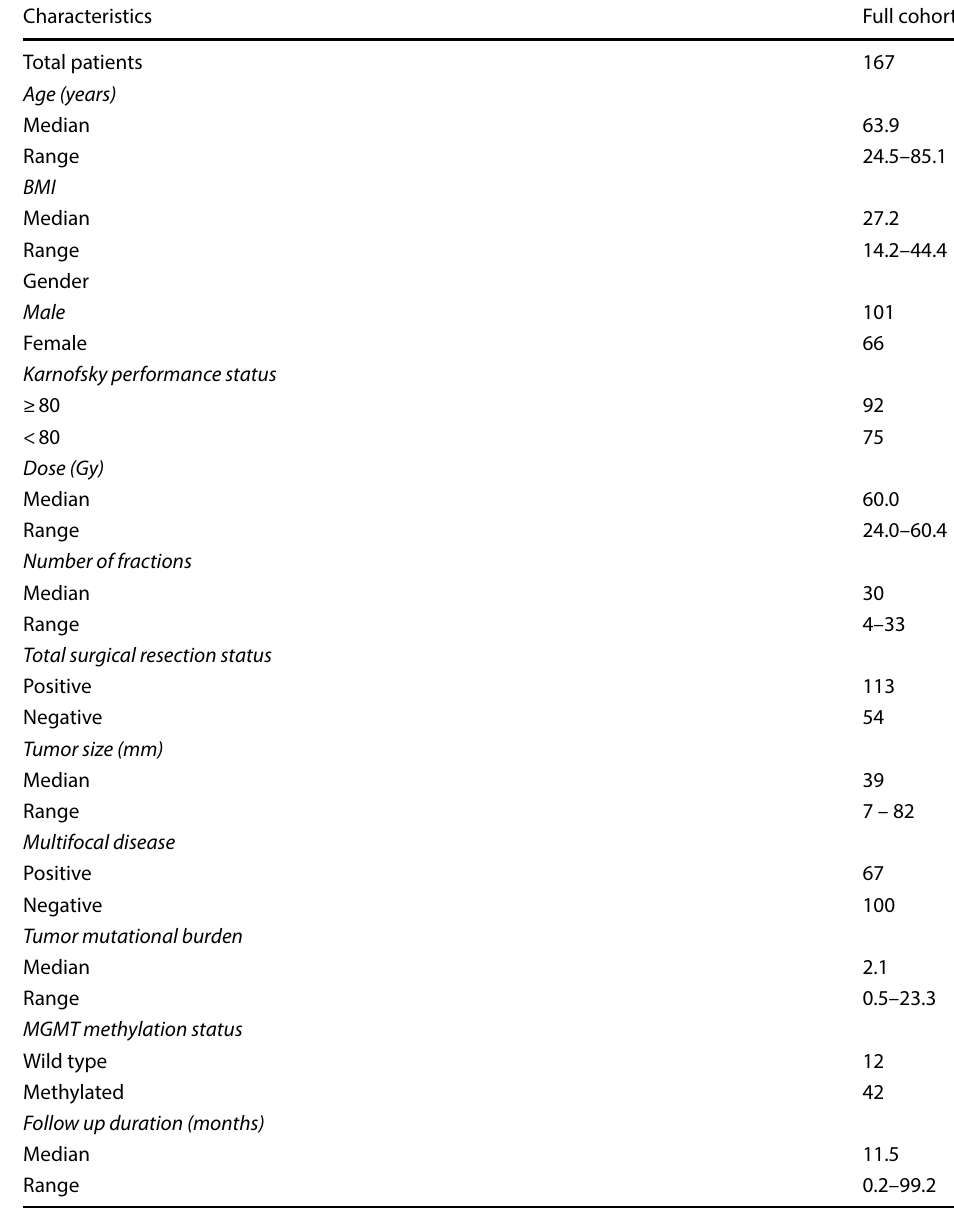
Table 1 Patient